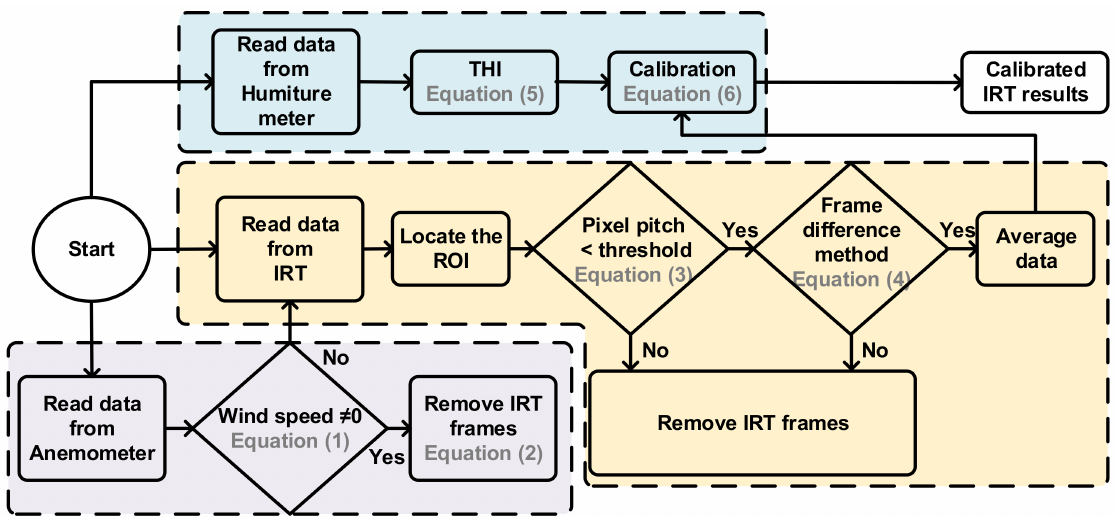
Figure 5. Signal processing flow of the proposed multiple sensors